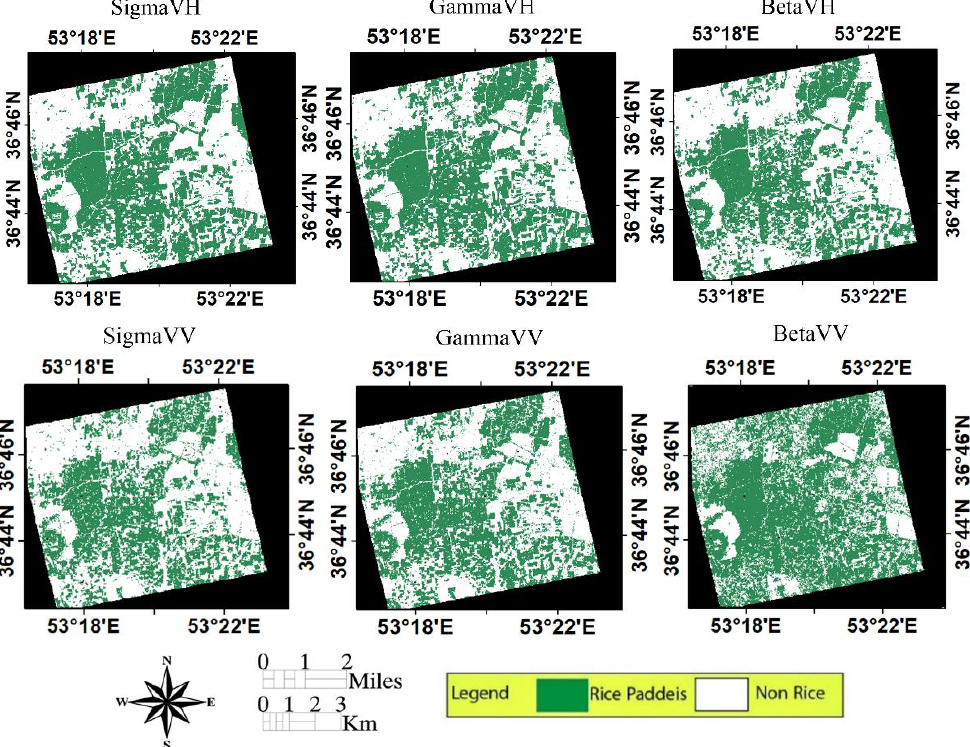
Figure 5. Rice crop map derived from Sentinel-1 time series images.